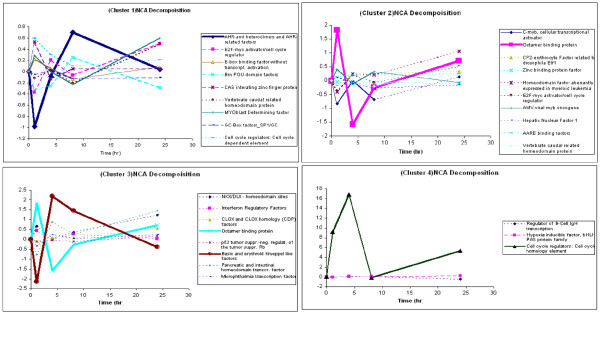
Typical profiles of Transcription Factor Activity Obtained from NCA. The transcription factors in bold are hypothesized as being more important based upon the scale of their activity. The cutoff was calculated by taking the transcription factor that showed the greatest difference over the experimental time period. Other transcription factors were included if their maximum difference was within the bootstrapped confidence intervals [85] of the originally selected profile.